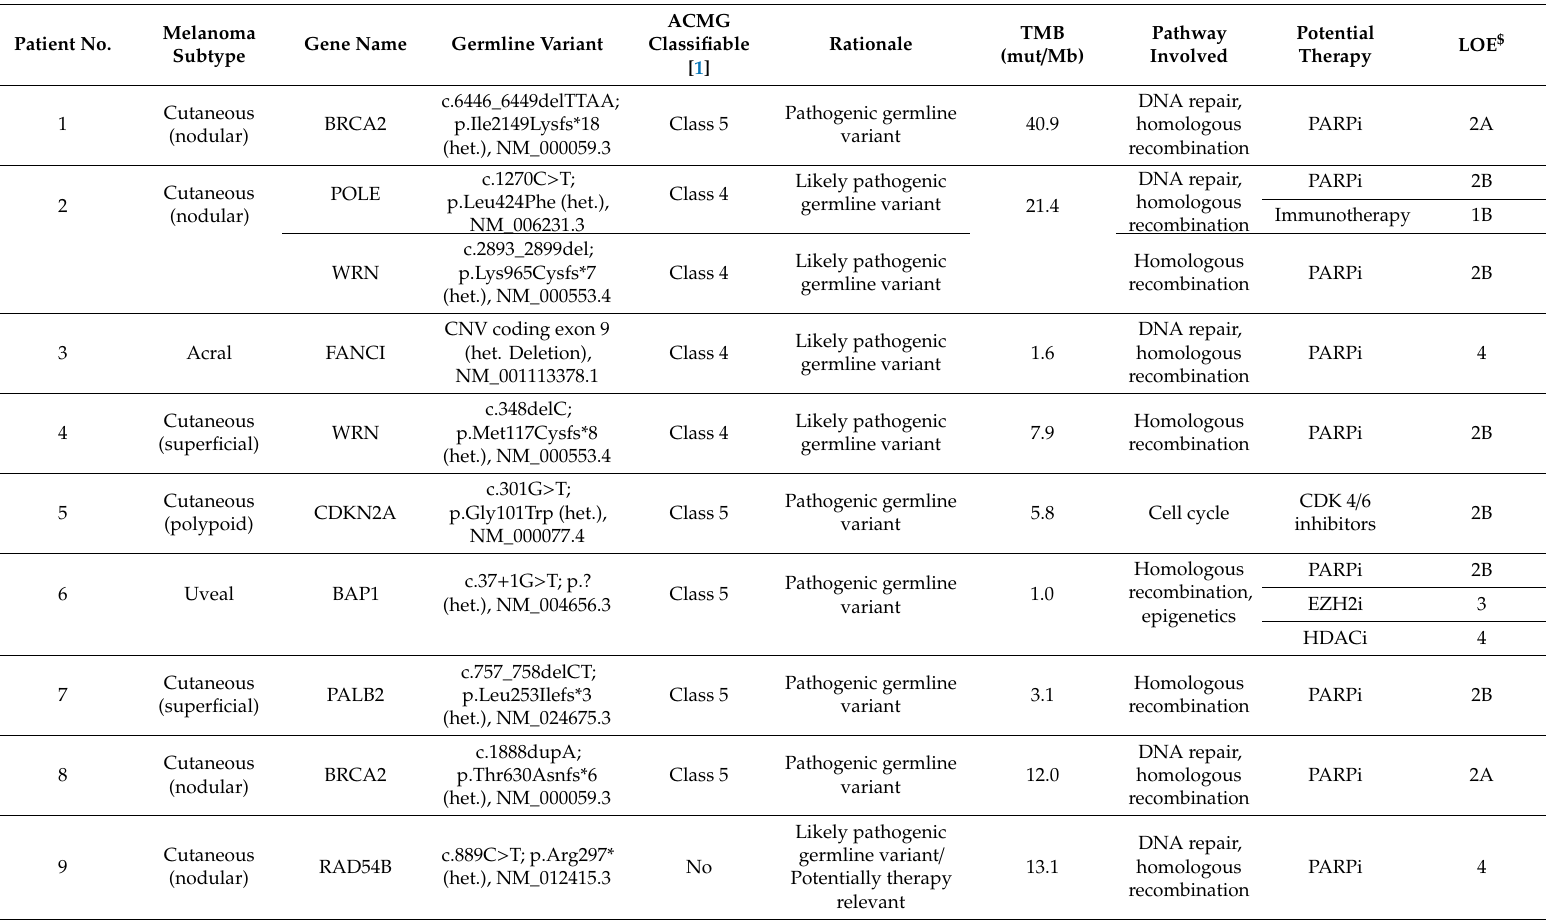
Table 1. Pathogenic and likely pathogenic germline variants